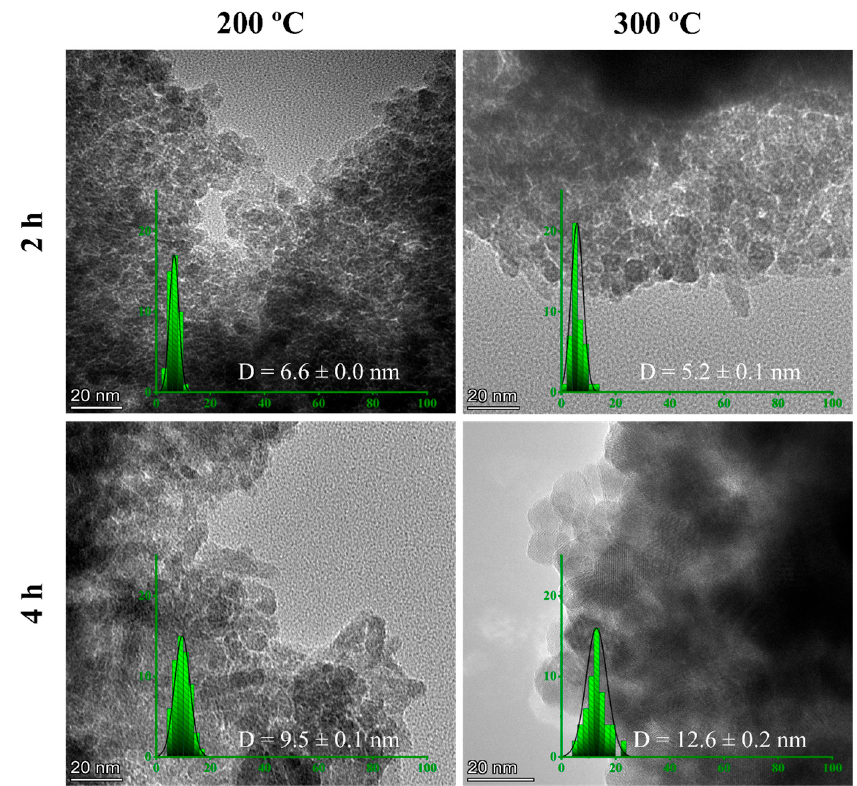
Figure 5. Transmission electron microscopy (TEM) of selected GS-NPs nanoparticles calcinated at temperatures (200 and 300 °C) and times (2 and 3 h).